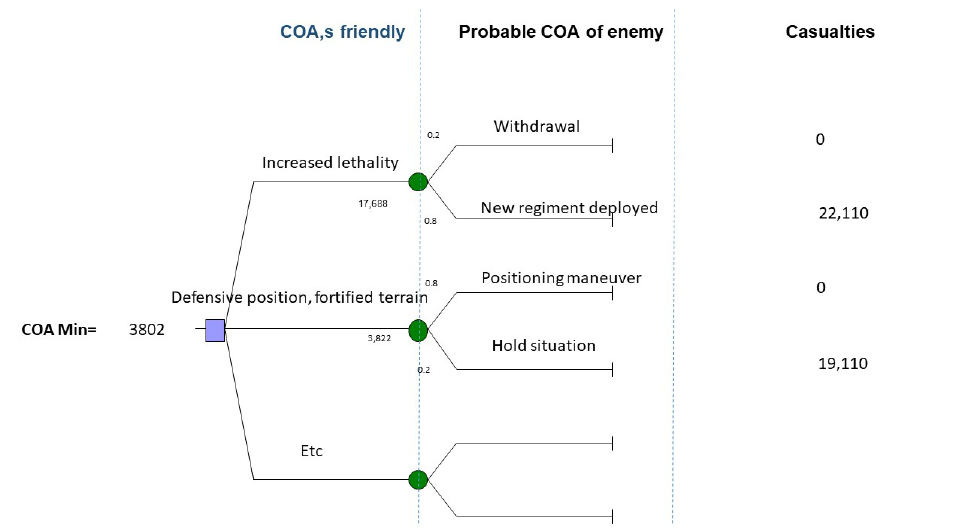
Figure 11. Development of the various courses of action, each Allie COA creates likely reaction alternatives for the German strategy quantified through its doctrine. The final expected value for each COA defines the best choice.